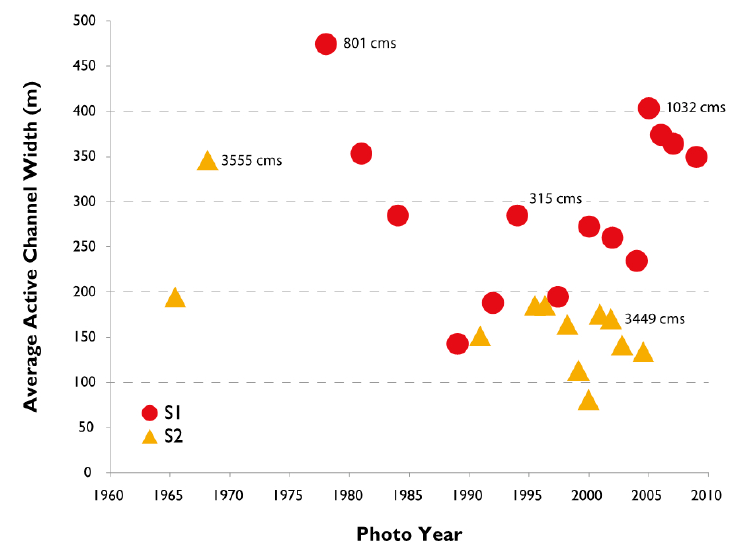
Figure 8. Average active channel width over time for sites S1 and S2. Selected flood discharges are shown.